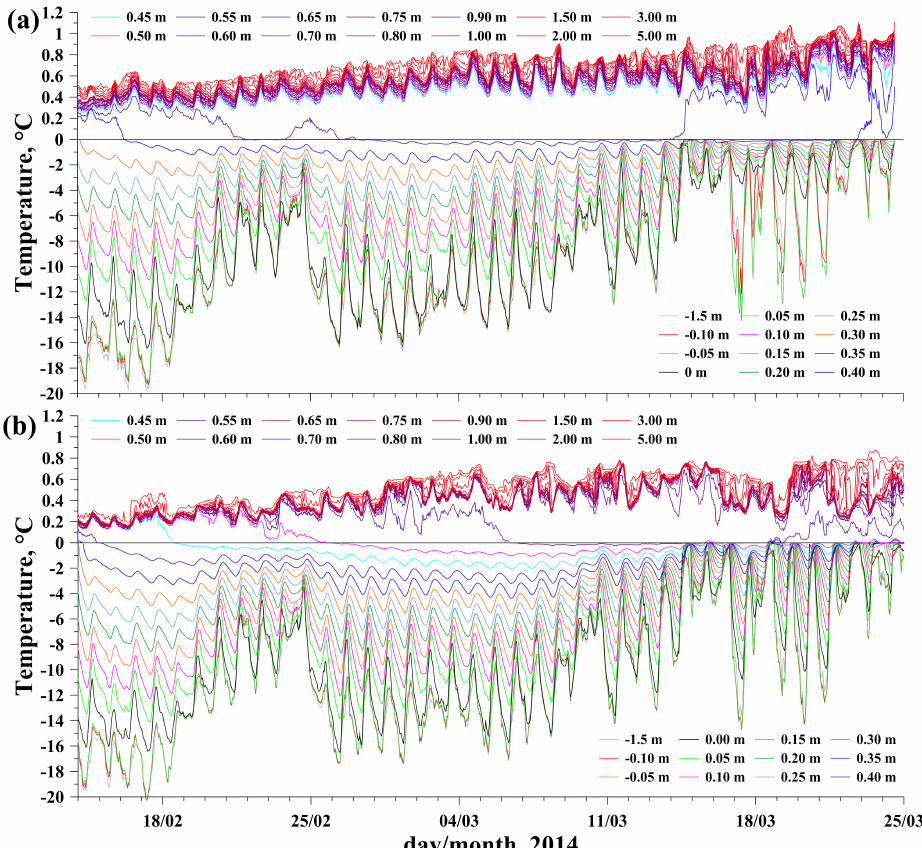
Figure 8. Temperatures in the ice, water and air at Station 1 ( a ) and Station 2 ( b ). The legends show the distance from sensors to the ice surface, positive direction — downward. Intersections of temperature curves with the abscissa (0 ◦ C) correspond to the times of sensor freezing in the ice. Note the different scales for positive and negative